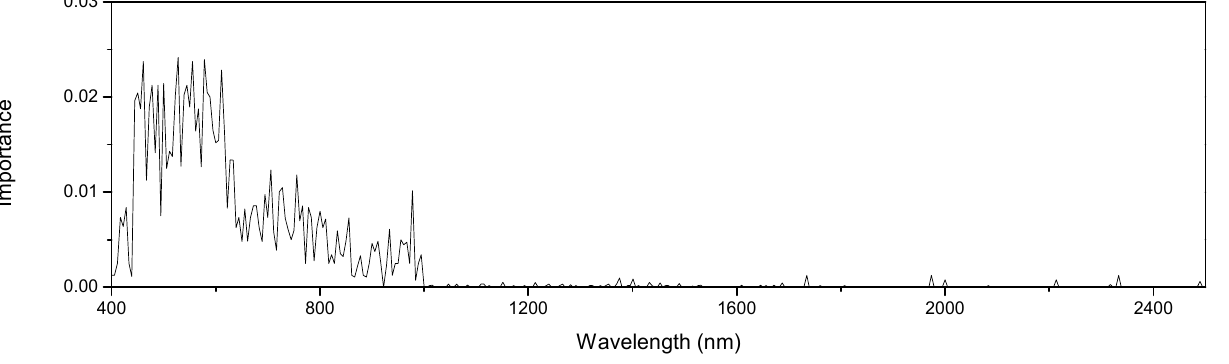
Figure 7. The importance of spectral bands under younger than 5 years or not provided by random